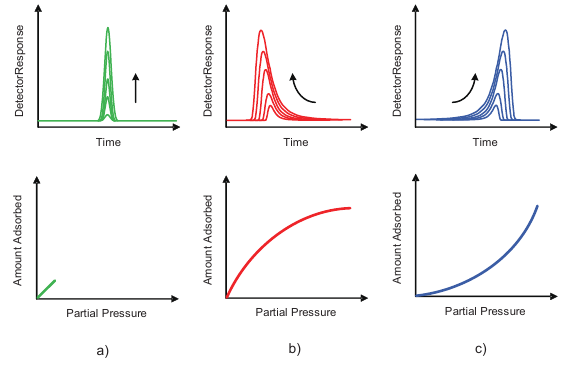
Fig. 1 IGC chromatograms at a) infinite dilution b) fi- nite concentration with ʻ tailing ʼ and c) finite con- centration with ʻ fronting ʼ